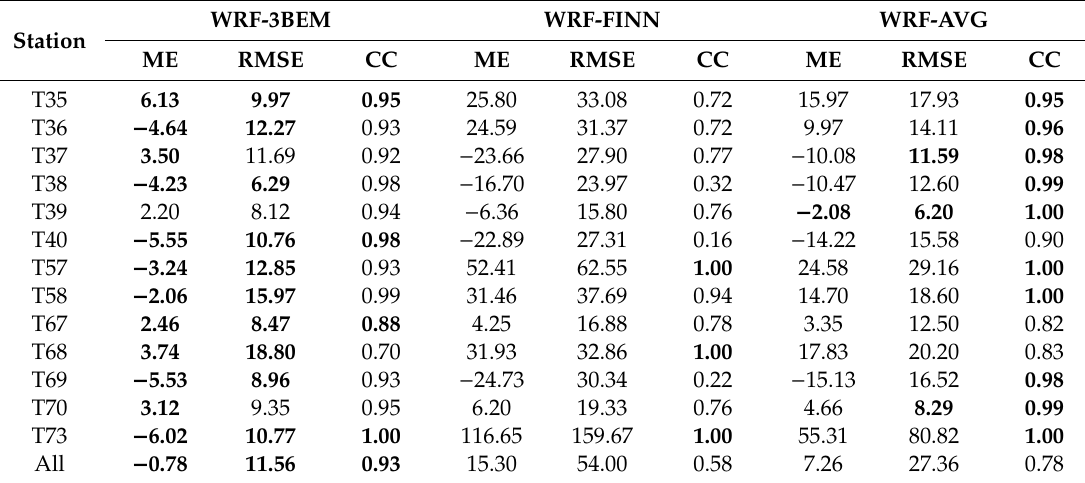
Boldface highlights the model performing best for each performance metric. Table 9. MEs (E[simulations-measurements]), RMSEs, and CCs of simulations and measurements